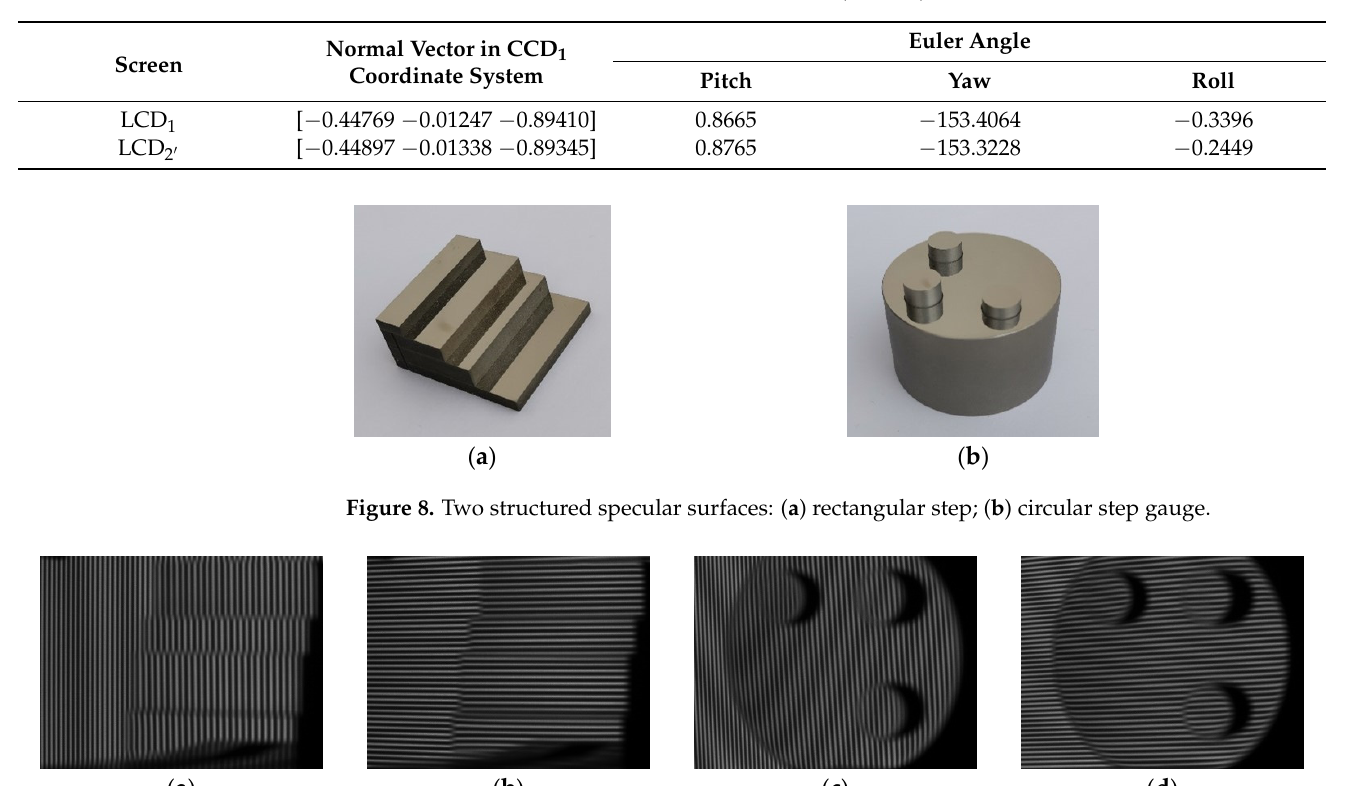
gular step; ( c , d ) circular step gauge.